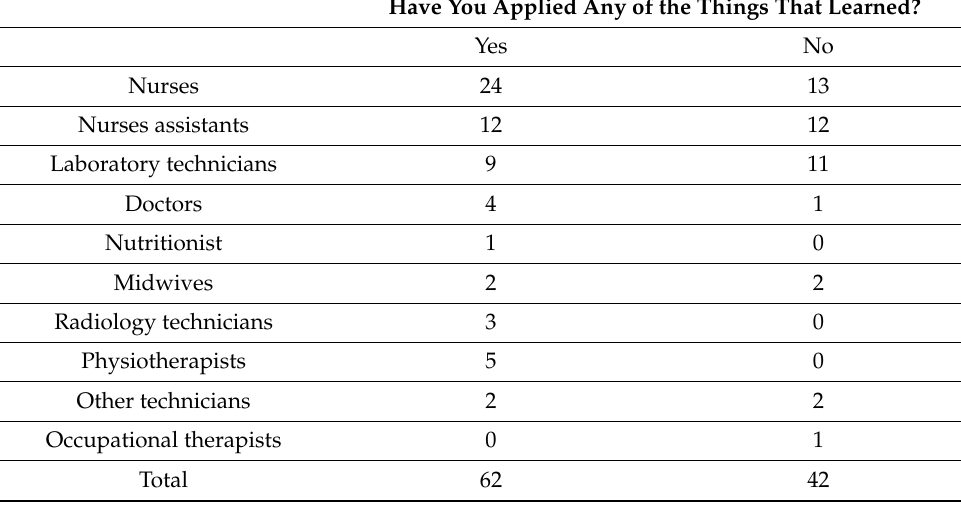
Table 2. Application and non-application of what has been learnt by professional profiles. Have You Applied Any of the Things That Learned?